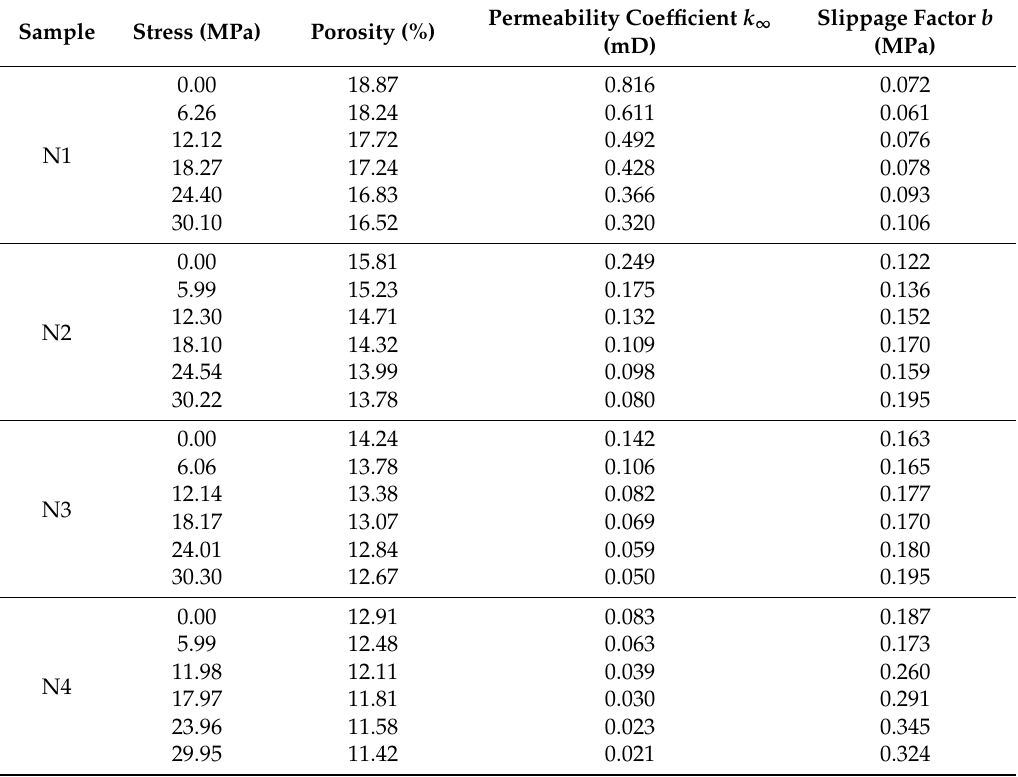
Table 3. The values of the Klinkenberg permeability parameters on coal samples N1–N4 using nitrogen. Sample